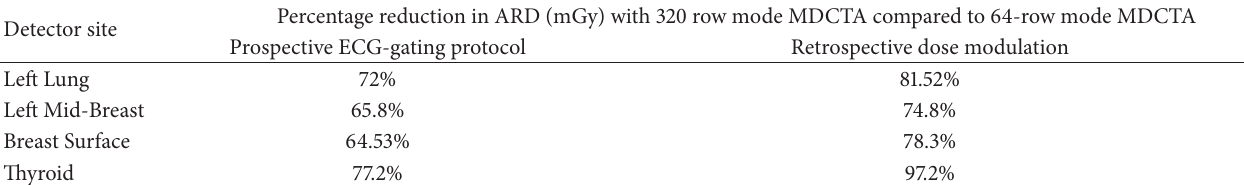
Table 6: Percentage reduction in ARD with 320-row compared to 64-row